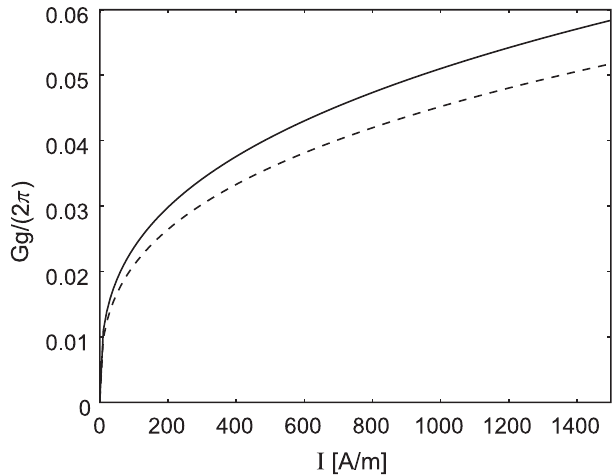
4. Normalized small signal gain for magnetized electron beam. The solid line corresponds to numerical solution of the dispersion relation Eq. (45) for magnetized electron beam, while the dashed line corresponds to PIC simulations